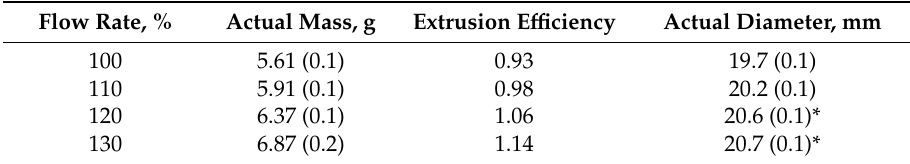
Figure 10. Cylindrical samples 3D printed with different flow rate settings, as labeled. Table 3. Short experiment on forced overflow data.